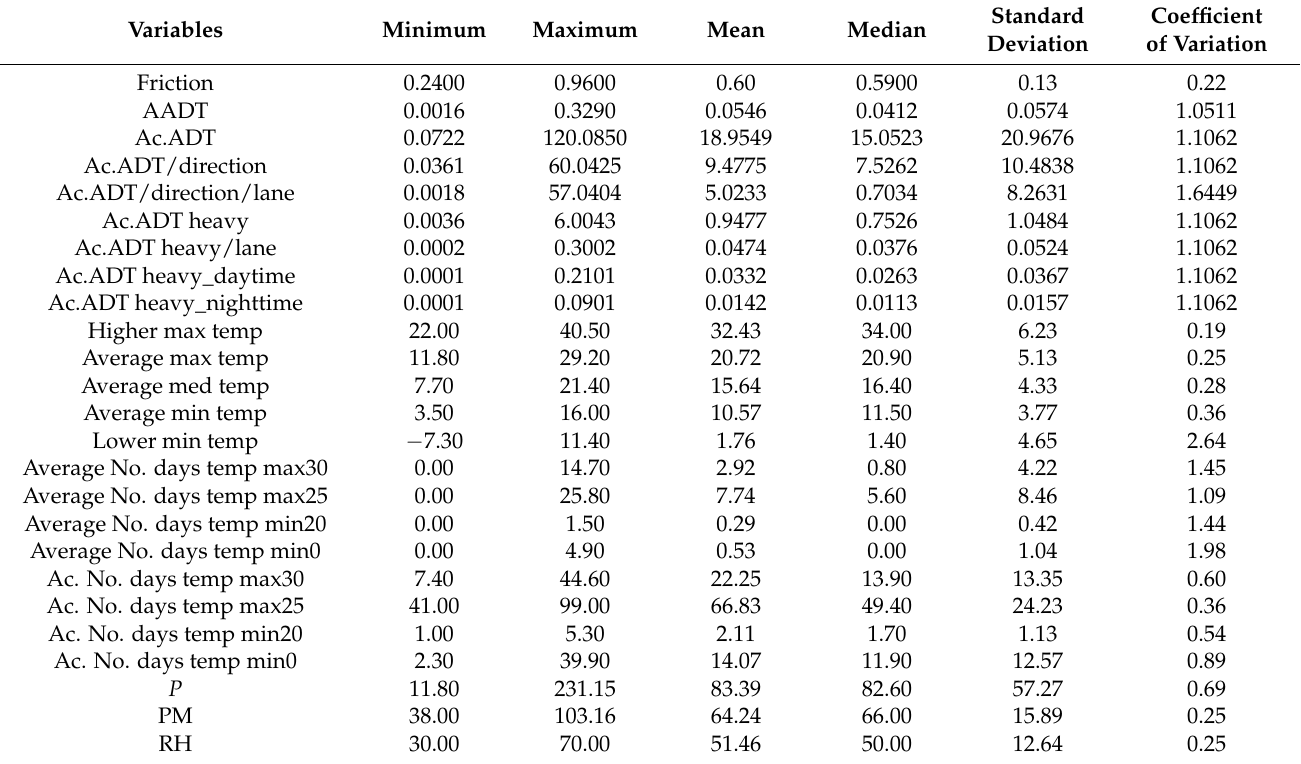
Table 5. Statistical summary of the quantitative